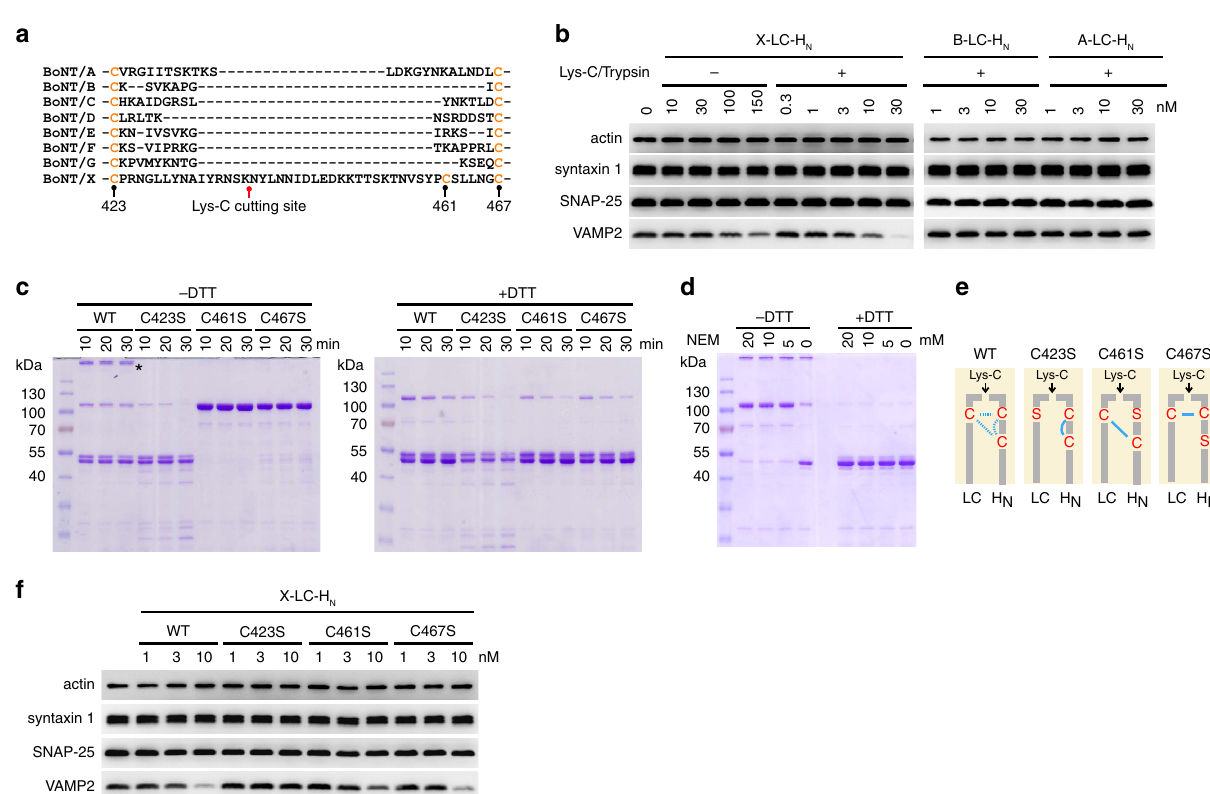
Figure 3 | Proteolytic activation and inter-chain disulfide bond in BoNT/X. ( a ) Sequence alignment of the linker between the LC and HC of the seven established BoNTs plus BoNT/X. The Lys-C cutting site was identified by mass spectrometry analysis (see Method and Supplementary Data 1). ( b ) Cultured rat cortical neurons were exposed to X-LC-H N for 12h. Cell lysates were harvested and immunoblot analysis carried out to examine syntaxin 1, SNAP-25 and VAMP2. Actin is a loading control. Trypsin-activated A-LC-H N and B-LC-H N were analysed in parallel. X-LC-H N entered neurons and cleaved VAMP2. X-LC-H N activated by Lys-C showed a greater potency than non-activated X-LC-H N . X-LC-H N was more potent than B-LC-H N and A-LC-H N , neither of which cleaved their substrates. ( c ) WTand mutant X-LC-H N were activated by Lys-C and analysed by SDS–PAGE and Coomassie Blue staining, with or without DTT. C461S and C467S mutants showed as a single band at B 100kDa without DTT, and separated into two B 50kDa bands with DTT. A portion of WT X-LC-H N formed aggregates, marked by an asterisk, which disappeared with DTT. The majority of activated WT X-LC-H N separated into two B 50kDa bands without DTT. This is due to disulfide bond shuffling as described in the following panel. ( d ) Lys-C-activated WT X-LC-H N was incubated with NEM to block disulfide bond shuffling. Samples were then analysed by SDS–PAGE and Coomassie Blue staining. A majority of WT X-LC-H N exists as a single band at B 100kDa without DTTafter NEM treatment, indicating that native WT X-LC-H N contains an inter-chain disulfide bond. ( e ) Schematic drawings of